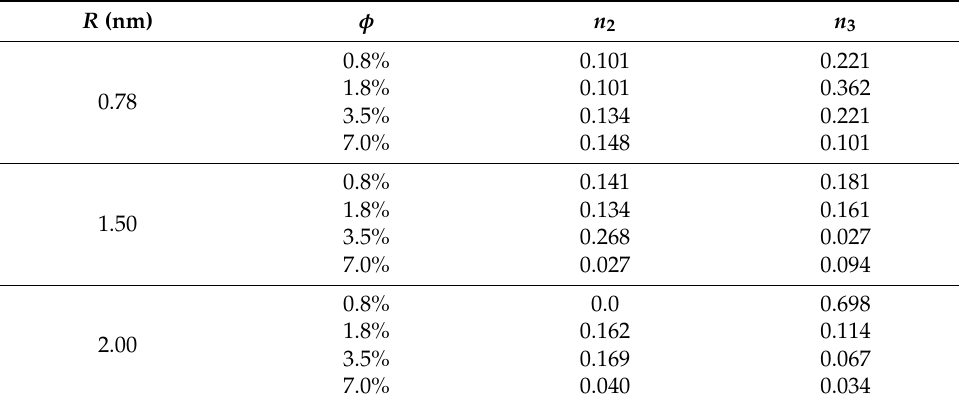
Table 3. Values of the numerical coefficients n 1 and n 2 used in Equations (13) and (14), obtained by minimizing the RMSE between the modelling predictions and the simulation data. The modified theoretical model allows to obtain an analytical description of the aggregation kinetic consistent with the predictions of the multi-scale model